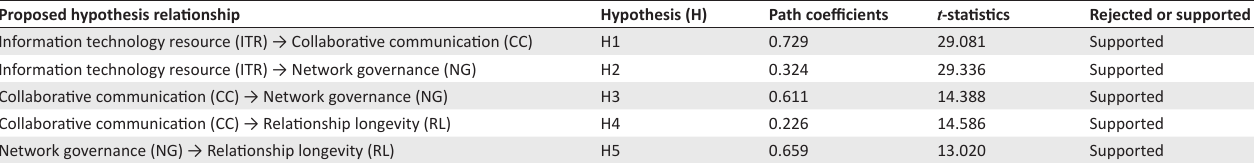
TABLE 4: Results of structural equation model analysis.